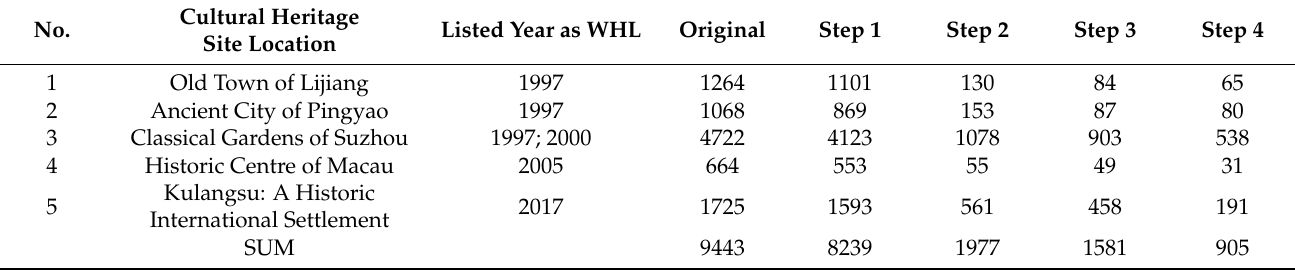
Table 2. The process of selection and purification of the relevant Weibo